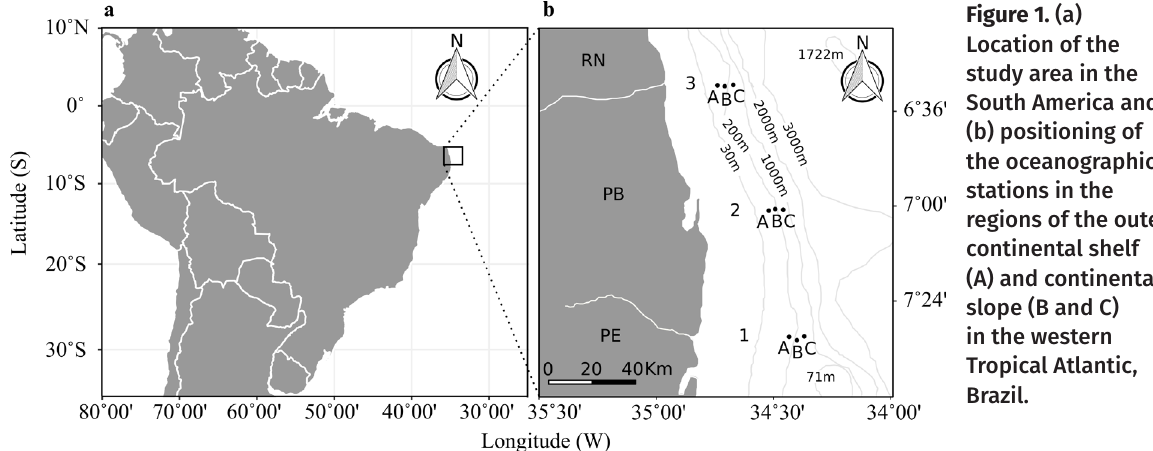
Figure 1. (a) Location of the study area in the South America and (b) positioning of the oceanographic stations in the regions of the